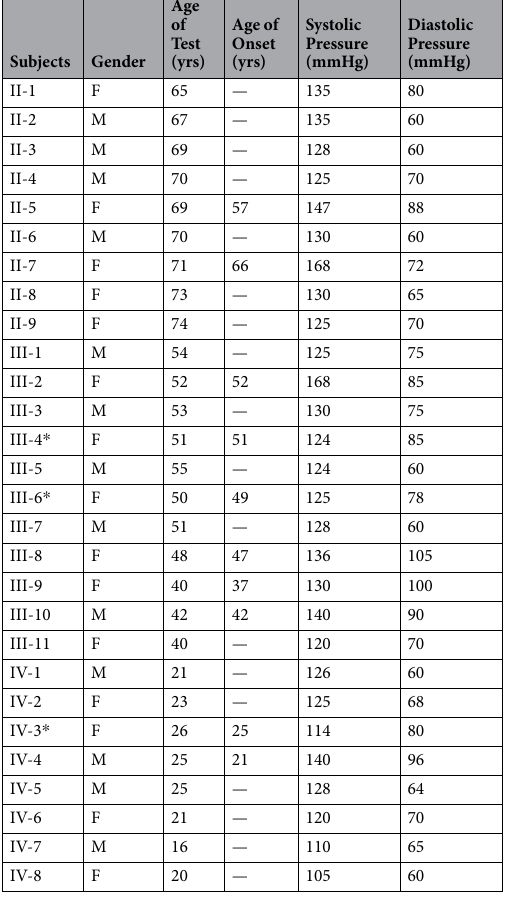
Table 2. Clinical Data for Some Members in a Large Chinese Pedigree. * These patients accept oral antihypertension treatment. This table shows post-treatment blood